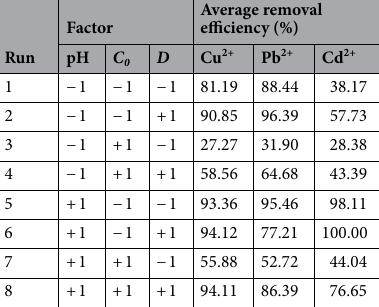
Table 2. Experimental factorial design results of heavy metal removal